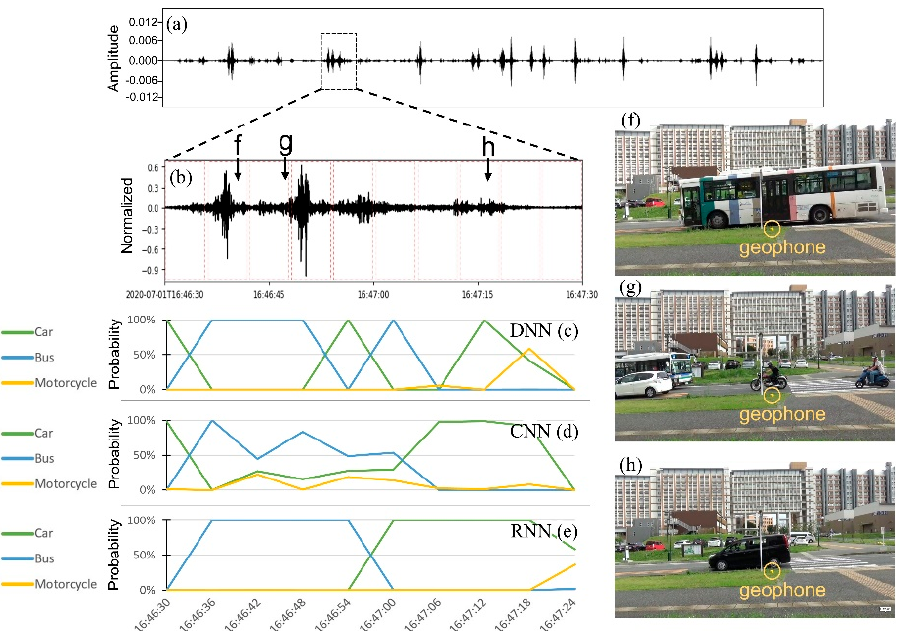
Figure 8. ( a ) A continuous seismic record 20 min long. ( b ) Detail of ( a ) showing a data window 1 min long divided into 5 s waveforms (red boxes) with gaps of 1 s between them. ( c ) The probabil- ity of vehicle types during the window in ( c ) is estimated using DNN, ( d ) CNN, and ( e ) RNN. Events during the window include the passage of ( f ) a bus, ( g ) a motorcycle, and ( h ) a car in mixed traffic. The vibrations recorded at times of pictures ( f ), ( g , h ) are displayed on panel ( b ).